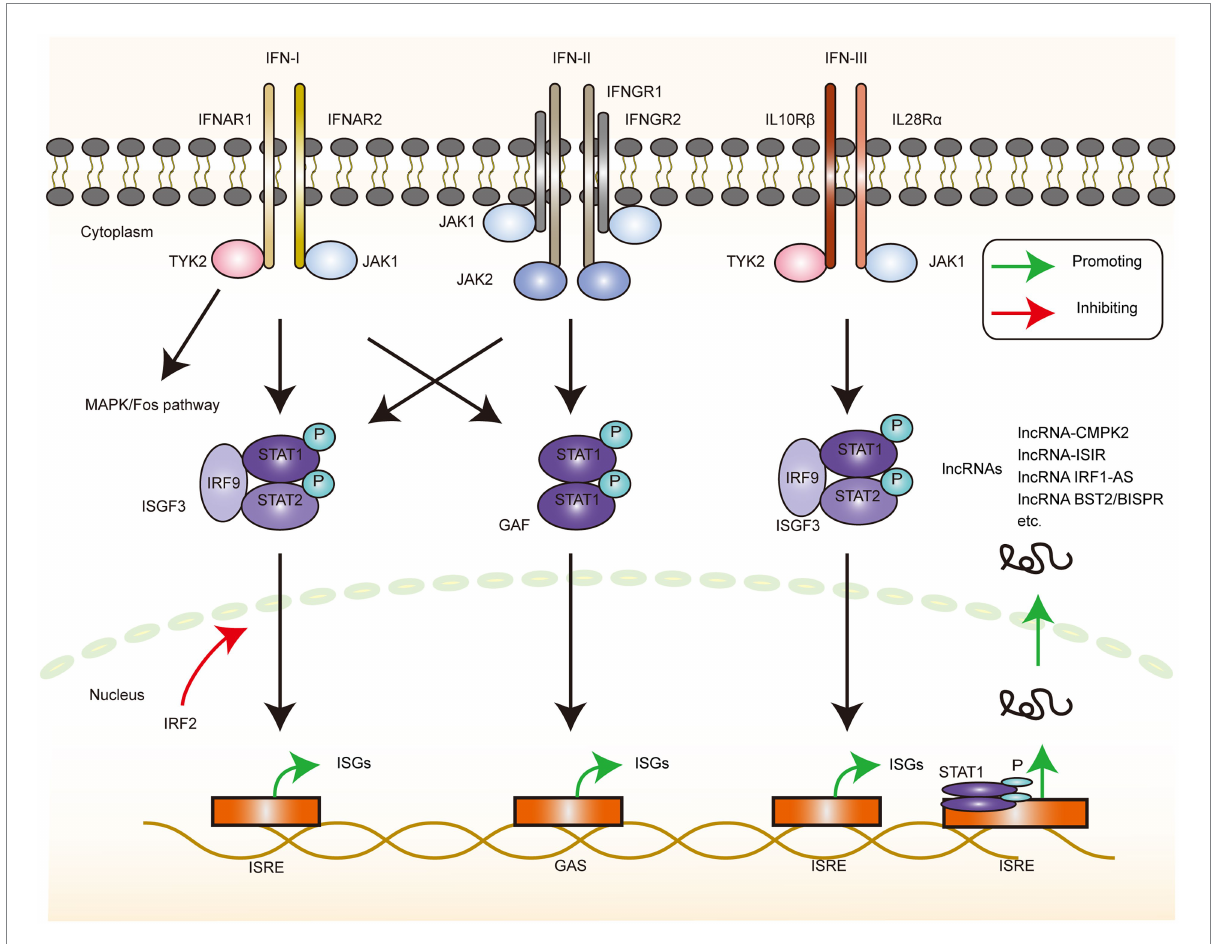
FIGURE 3 ISGs production via interferon stimulation. The depiction of the downstream signaling pathway changes that occur when the 3 types of interferon receptors bind the corresponding IFN ligands. IFN-I can induce changes in the downstream gene transcription levels via the MAPK/Fos, JAK1- TYK2/ISGF3, and JAK1-TYK2/GAF pathways, with IRF2 serving as a negative regulator of the ISGF3 pathway. IFN-II induces changes in the downstream gene-transcriptional regulation via the JAK1-TYK2/ISGF3 and JAK1-JAK2/GAF pathways. IFN-III produces the downstream gene expression changes via the JAK1-TYK2/ISGF3 pathway. These genes can also be lncRNA, and the current experiments directly or indirectly demonstrated the signaling pathways that upregulate the corresponding lncRNA, mainly through the JAK1/STAT1 pathway, resulting in the production of further biological